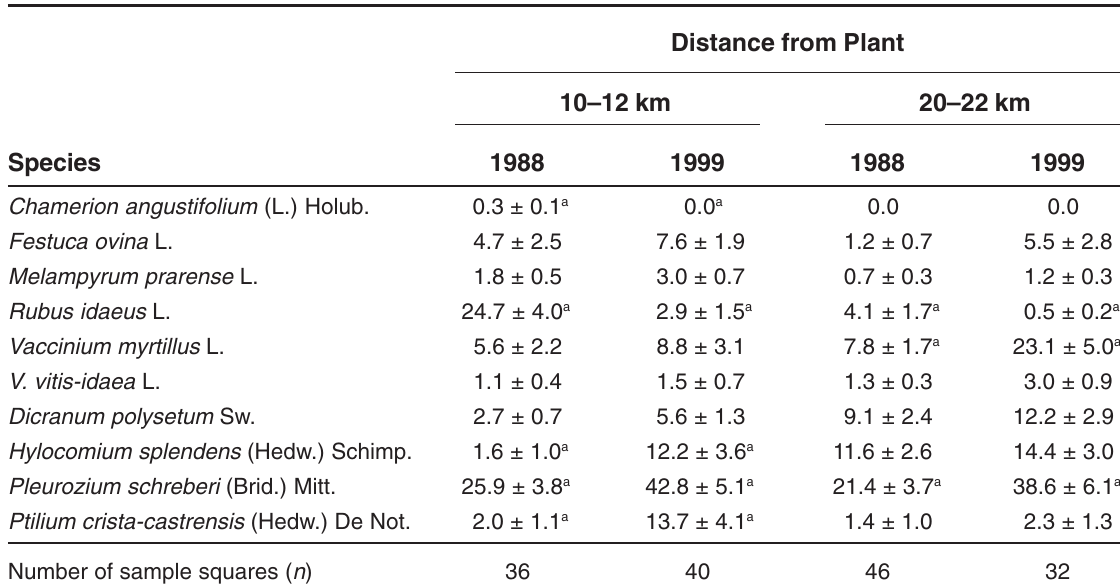
Mean Coverage by the Main Species of Vaccinio-myrtillosa of the Forest Type in Scots Pine Stands Near the JV Achema Plant